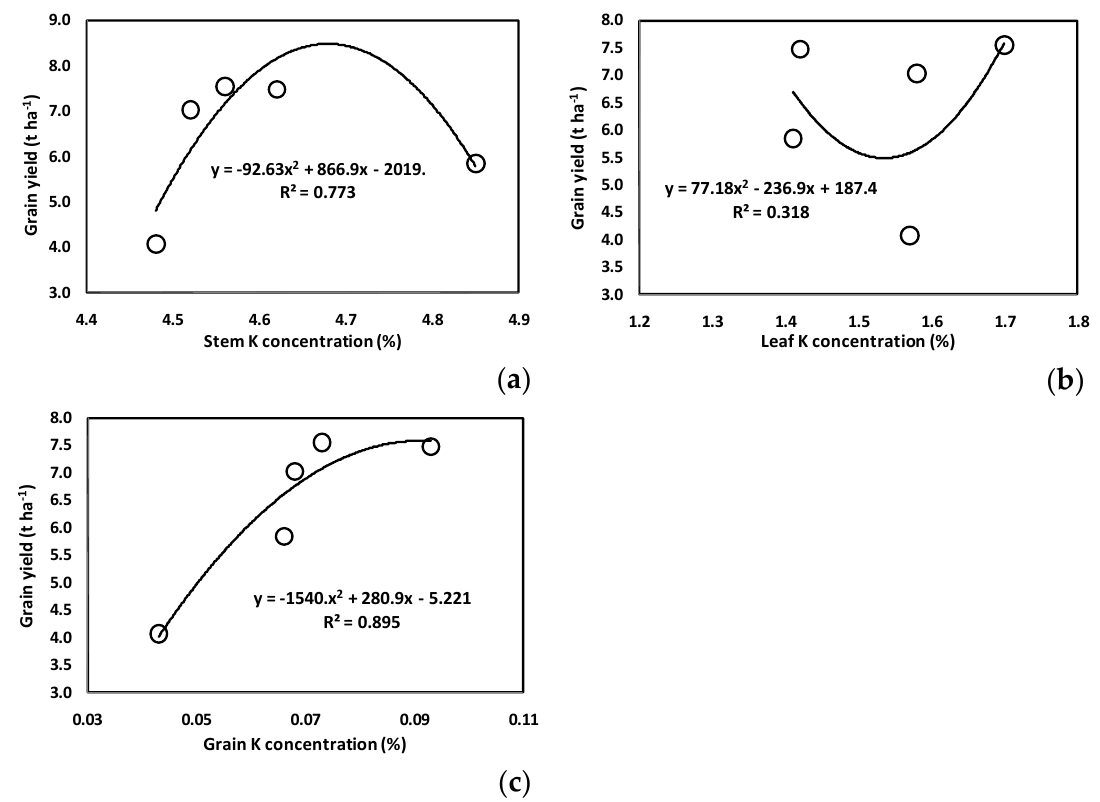
Figure 2. Relationship between grain yield (t ha − 1 ) and stem ( a ), leaf ( b ), and grain ( c ) K concentration (%).